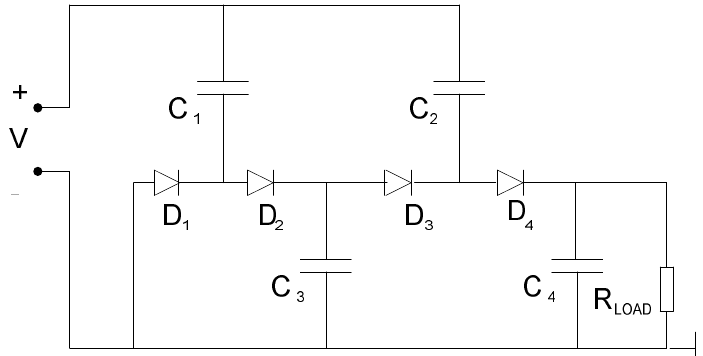
Figure 15. Karthaus Fisher Cascade Voltage Doubler (KFCVD) circuit. Again, the single stage proposed by the Greinacher voltage doubler is reproduced here in several stages, increasing the level of obtainable voltage.